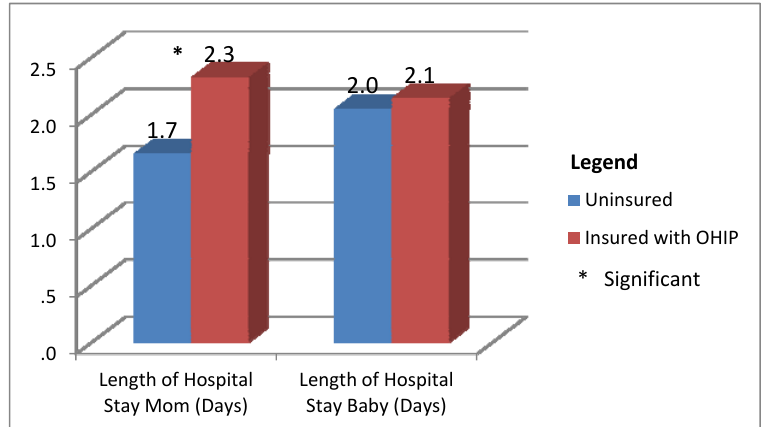
Figure 5. Mean length of hospital stay by insurance status ( n =